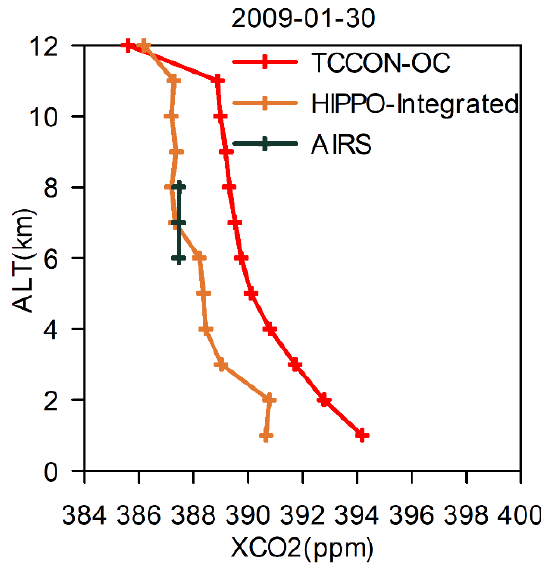
Figure 6. Spatial validation of AIRS daylit average XCO 2 vertical profiles on 30 January 2009. The red line shows the TCCON ‐ OC CO 2 profile. The orange line indicates the profile of HIPPO integration. The dark ‐ green line is XCO 2 of AIRS at mid ‐ troposphere.